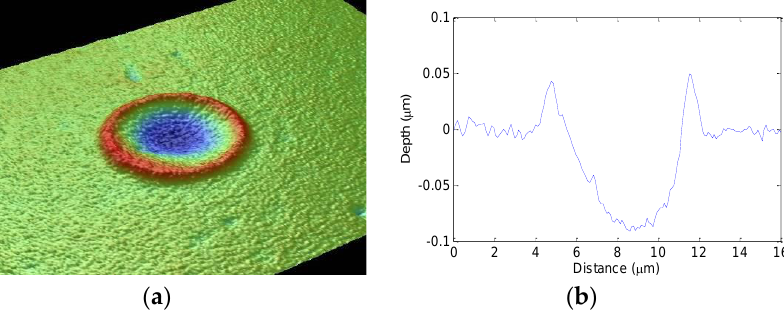
Figure 1. ( a ) 3D visualization of a single shot ablation crater from optical profilometry. ( b ) 2D cross-sectional data indicating the diameter and depth of the crater (Veeco NT3300, Bruker Nano Surface, Tucson, AZ, USA).